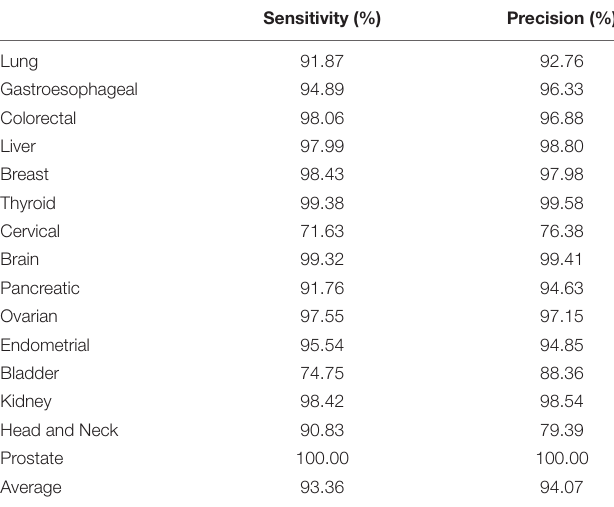
TABLE 2 | Sensitivity and precision assessment for each cancer type.